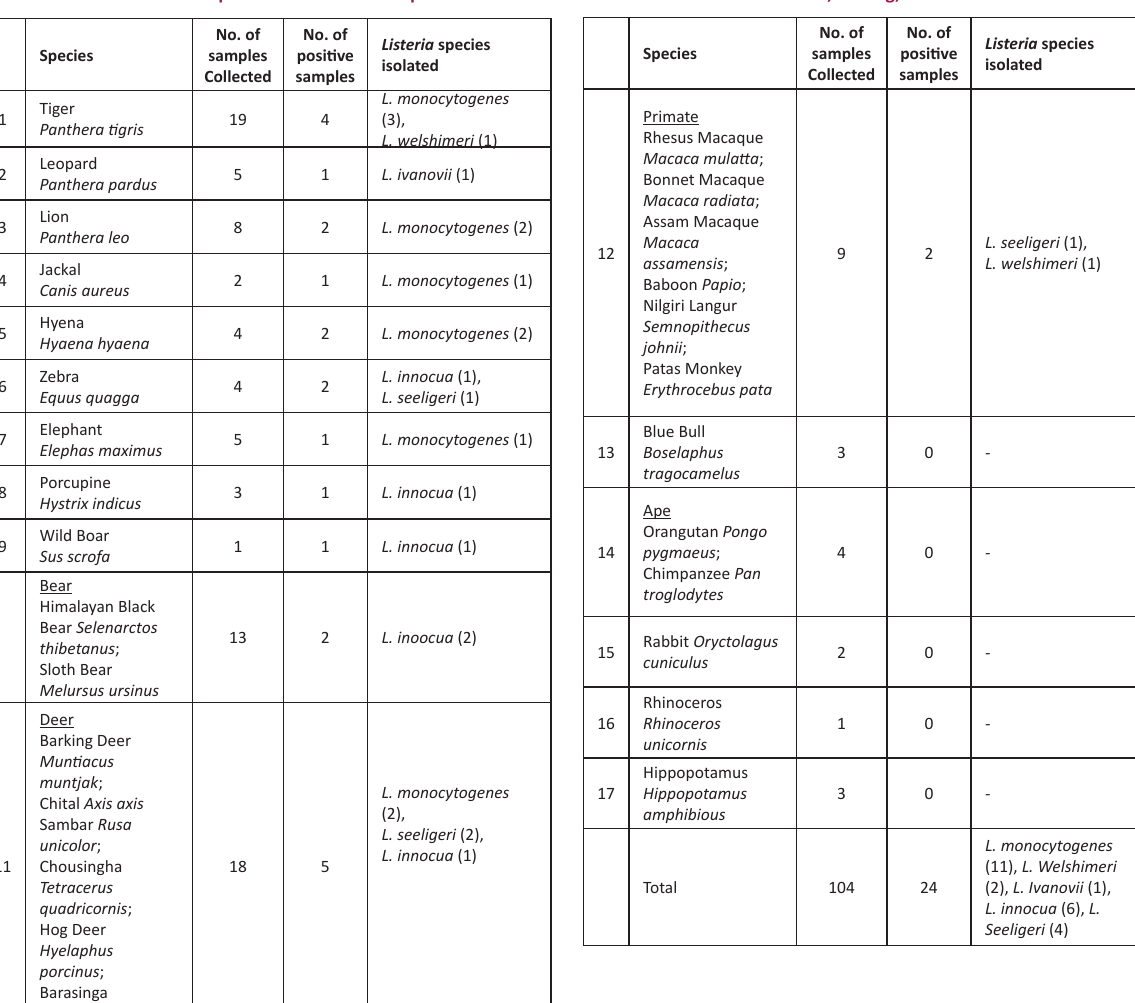
Table 1. Isolation of Listeria species from Faecal samples of different wild animals of Nandankanan Zoo, Barang,